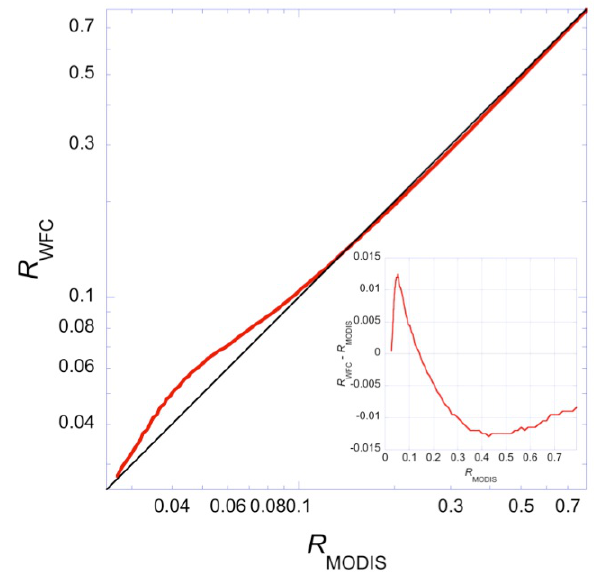
Fig. 2. Comparison of WFC and MODIS 0.65µm reflectances at the first, second, third, ..., 99th percentiles of the overall WFC and MODIS reflectance histograms. Inset: difference between WFC and MODIS reflectances at each percentile bin, plotted on a linear